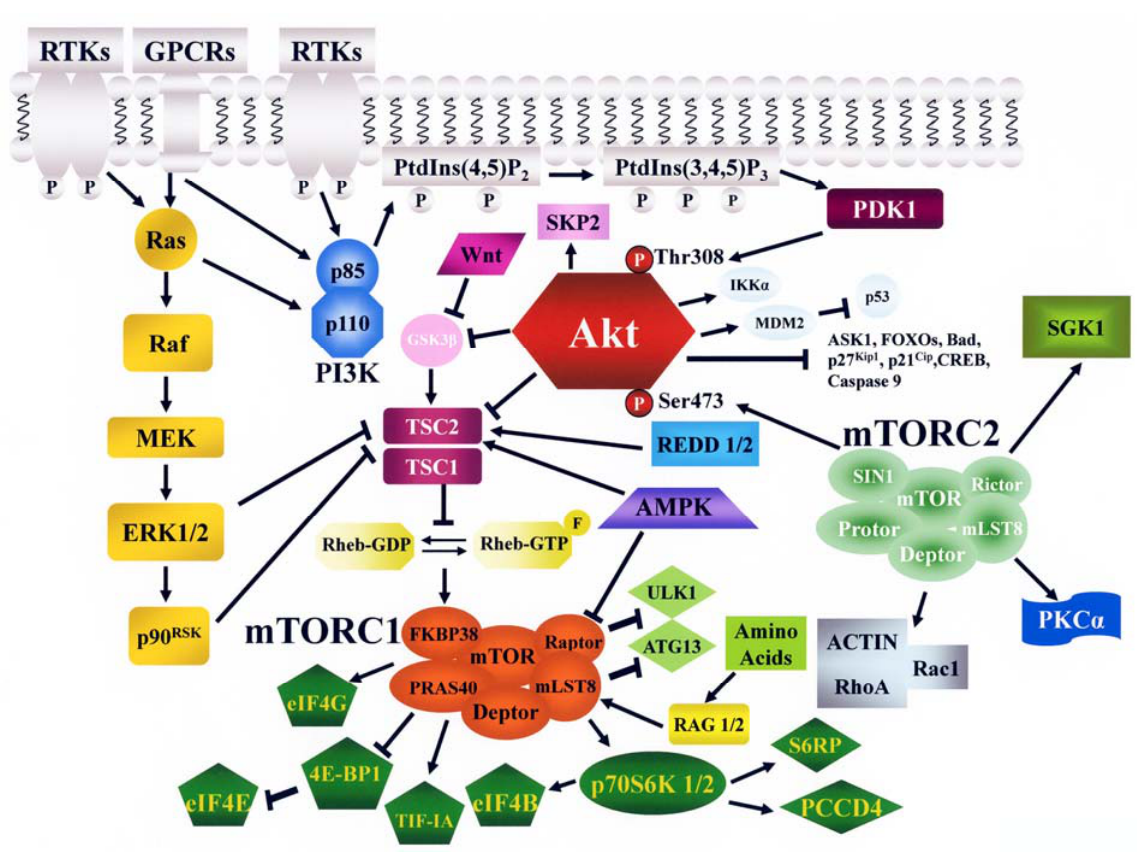
Figure 1. The PI3K/Akt/mTOR signaling pathway. RTKs, GPCRs, and Ras stimulate class I PI3K activity. PI3K generates PtdIns 3,4,5P3 from PtdIns 4,5, P2. PtdIns 3,4,5P3 attracts to the plasma membrane PDK1 which phosphorylates Akt on Thr 308. Full Akt activation requires Ser 473 phosphorylation by mTORC2. Active Akt inhibits TSC2 activity through direct phosphorylation. TSC2 is a GAP that functions in association with TSC1 to inactivate the small G protein Rheb. Akt-driven TSC1/TSC2 complex inactivation allows Rheb to accumulate in a GTP-bound state. Rheb-GTP upregulates the protein kinase activity of mTORC1. However, other signals impinge on mTORC1, including the Ras/Raf/MEK/ERK1/2/p90 RSK pathway, the AMPK network, RAG 1/2, REDD 1/2, Wnt/GSK3  . mTORC1 targets p70S6K 1/2 and 4E-BP1 which are critical for translation. S6RP, eIF4B, and PCCD4 are targets of p70S6K 1/2. mTORC2 regulates actin polymerization and phosphorylates PKC  and SGK1. Arrows indicate activating events, whereas perpendicular lines highlight inhibitory